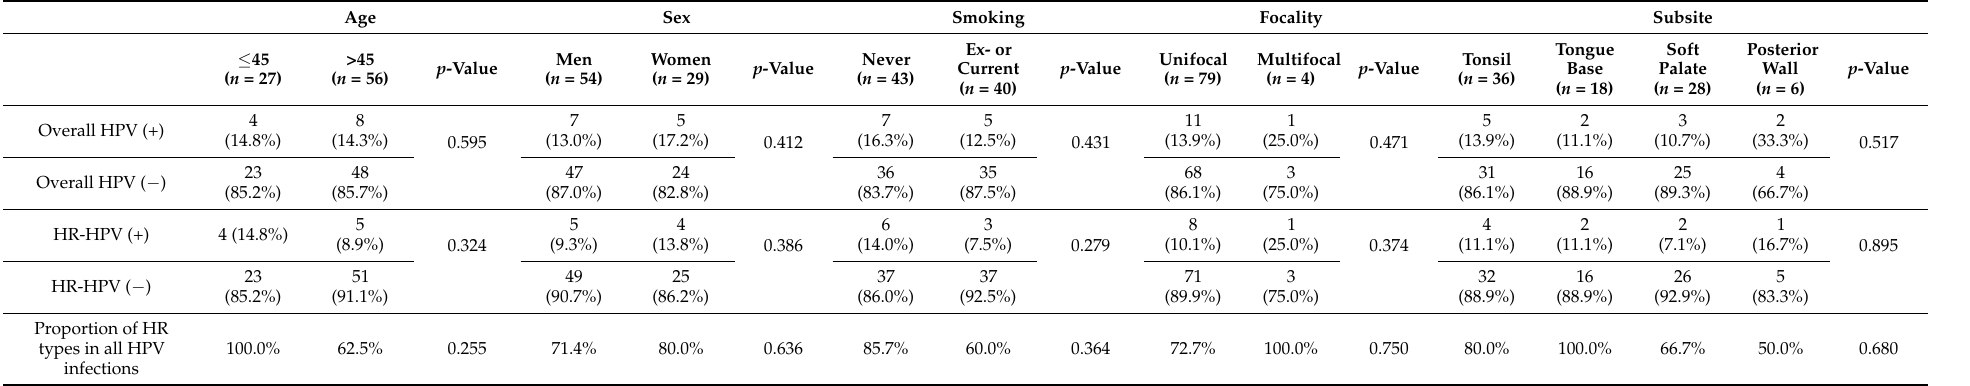
Table 4. Prevalence of HPV infection according to clinicodemographic